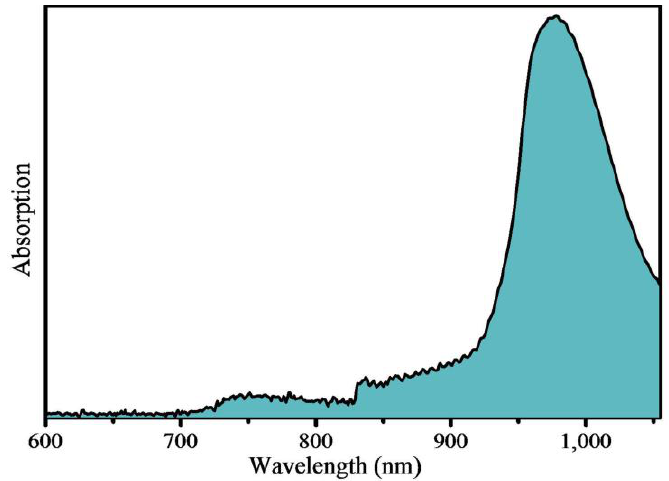
Figure 1. Absorption of water in the NIR